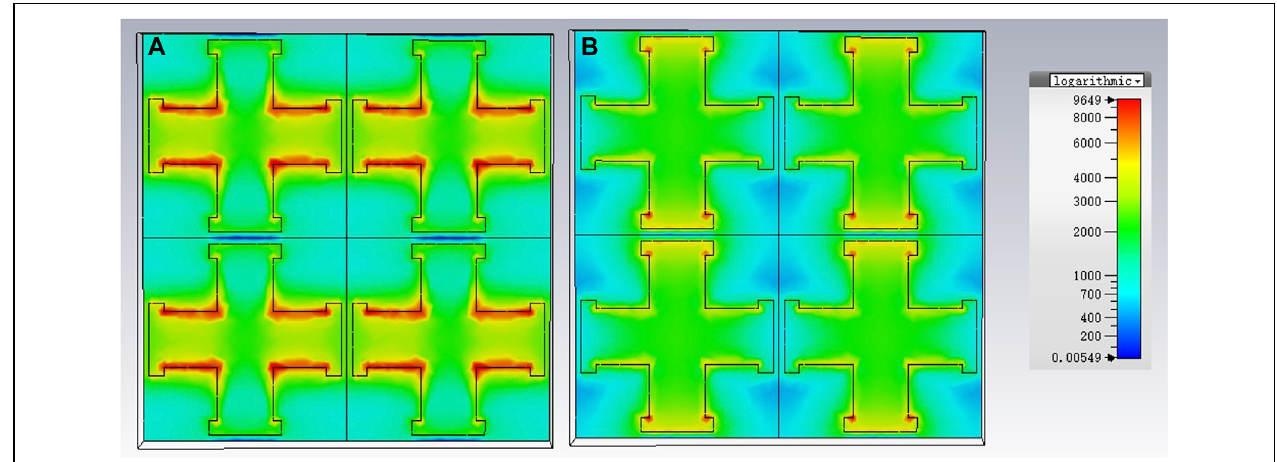
FIGURE 8 | Schematic diagram of the electric field distribution on the surface under TE polarization. (A) Frequency at 23 GHz. (B) Frequency at 10 GHz.